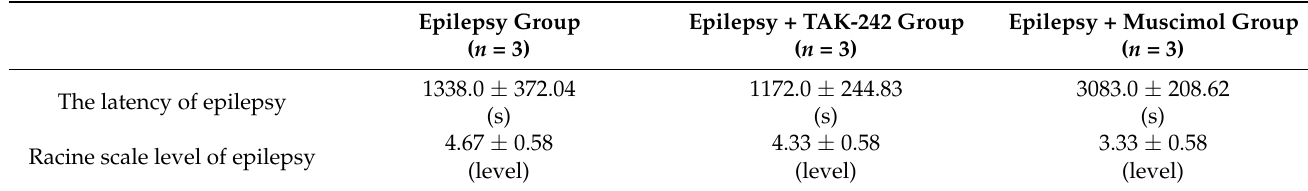
Table 4. The latency and Racine scale level of epilepsy in different groups of rats.